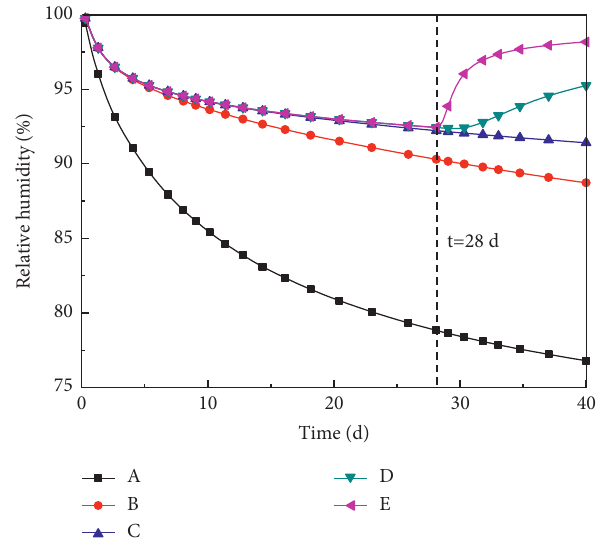
Figure 5: Variations of RH at different monitoring points.